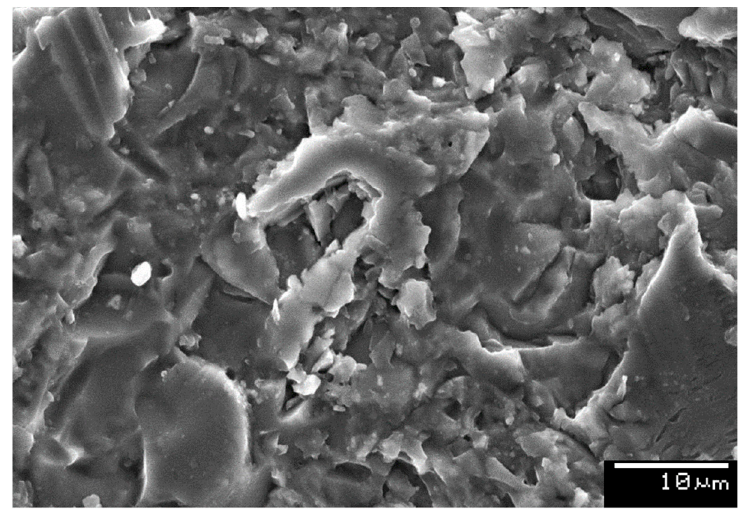
Figure 2. Group B: surface treatment of diamond bur on the ceramic surface at ×2000 under SEM.